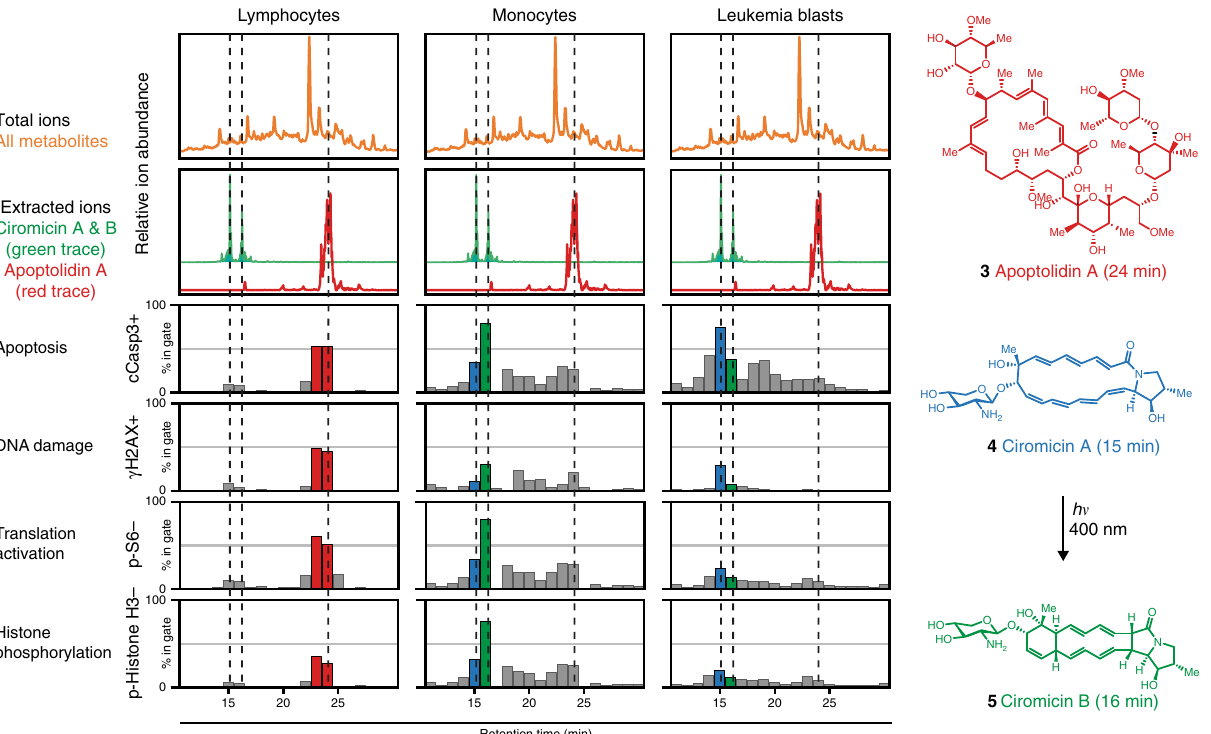
Fig. 4 An optochemical cell selectivity switching natural product in Nocardiopsis revealed by primary cell MAM. The top metabolome row (orange) shows total ion current and extracted ions for ciromicins A and B ( m/z = 515, 15, and 16 min) and apoptolidin ( m/z = 1129.5, 23.4 min) with their elution times shown in dotted lines. The next four rows show selected bioactivity chromatograms from a single fl ow experiment, which were generated by adding an aspirated preparation of bone marrow mononuclear cells from an AML patient, barcoding, immunostaining, and debarcoding. The immunostaining panel contained CD45 (leukocyte-common antigen), cCasp3 (cleaved caspase), γ H2AX (DNA damage), p-Histone H3 (cell cycle marker upregulated during mitosis), and p-S6 (marker for active translation). The average collected per well was 5400 blasts (minimum 209), 750 monocytes (minimum 19), and 291 lymphocytes (minimum 20). Histograms for each marker for highlighted wells are shown in Supplementary Fig.